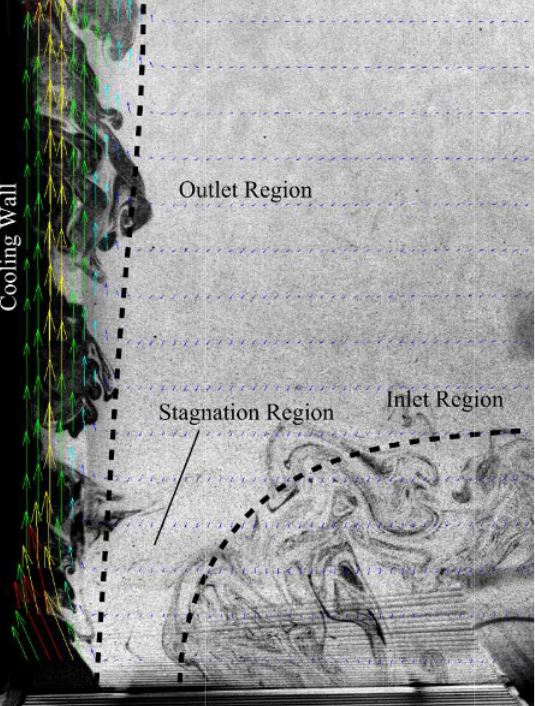
Fig. 4. The flow patterns above the